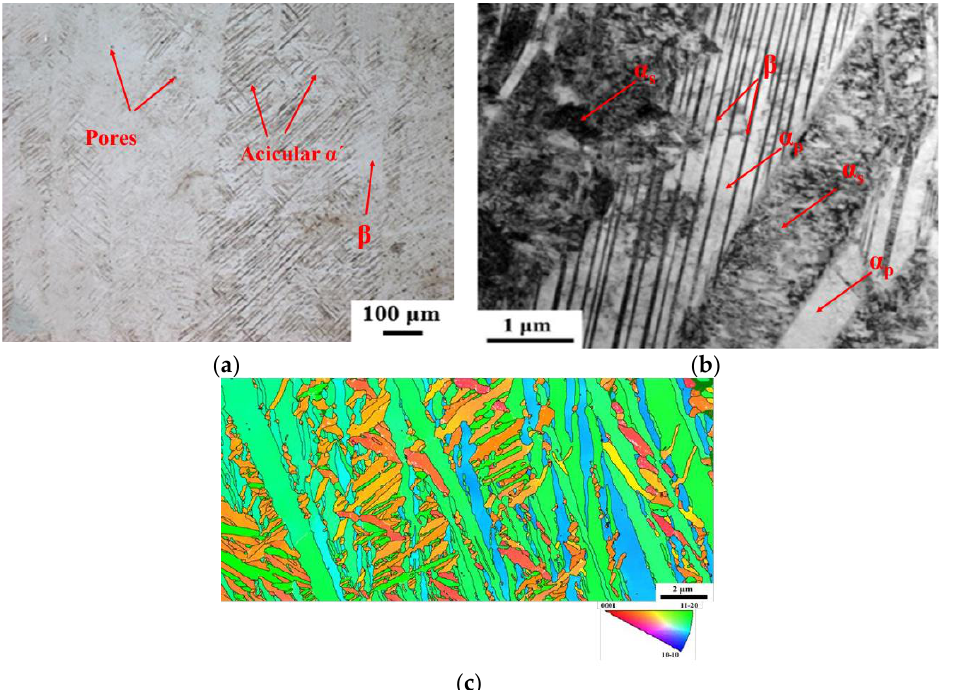
Figure 4. ( a ) Optical microscopy, ( b ) TEM microstructure and ( c ) EBSD of SLMed Ti-6Al-4V